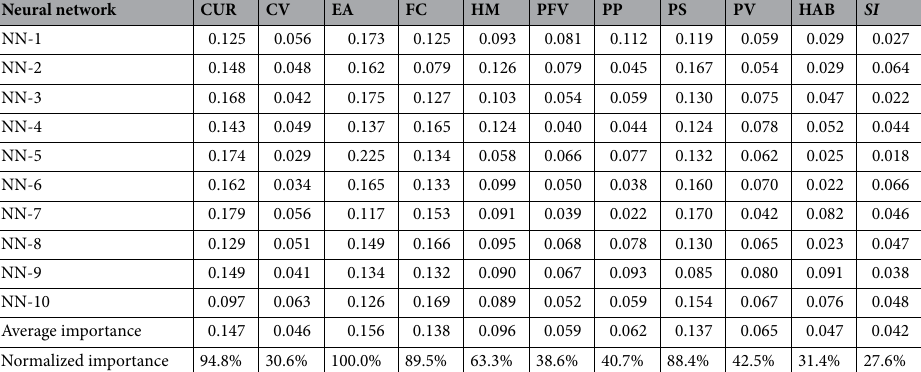
Table 9. Sensitivity analysis. PP = Perceived Performance; PFV = Perceived Functional Value; PV = Perceived Value; PS = Perceived Satisfaction; HAB = Habit; HM = Hedonic Motivation; CUR = Curiosity; SI = Social Influence; EA = Environmental Awareness; FC = Facilitating Condition; CV = Cost Value.